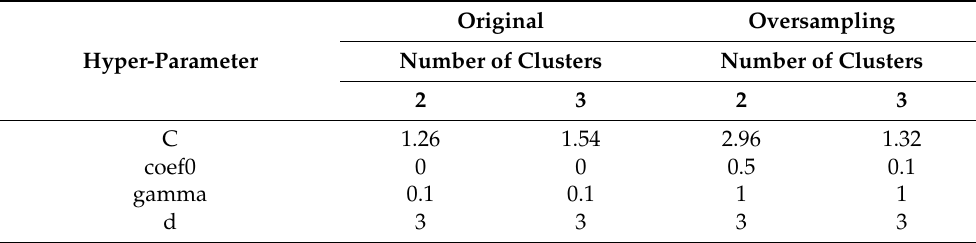
Table 1. Hyperparameters for support vector